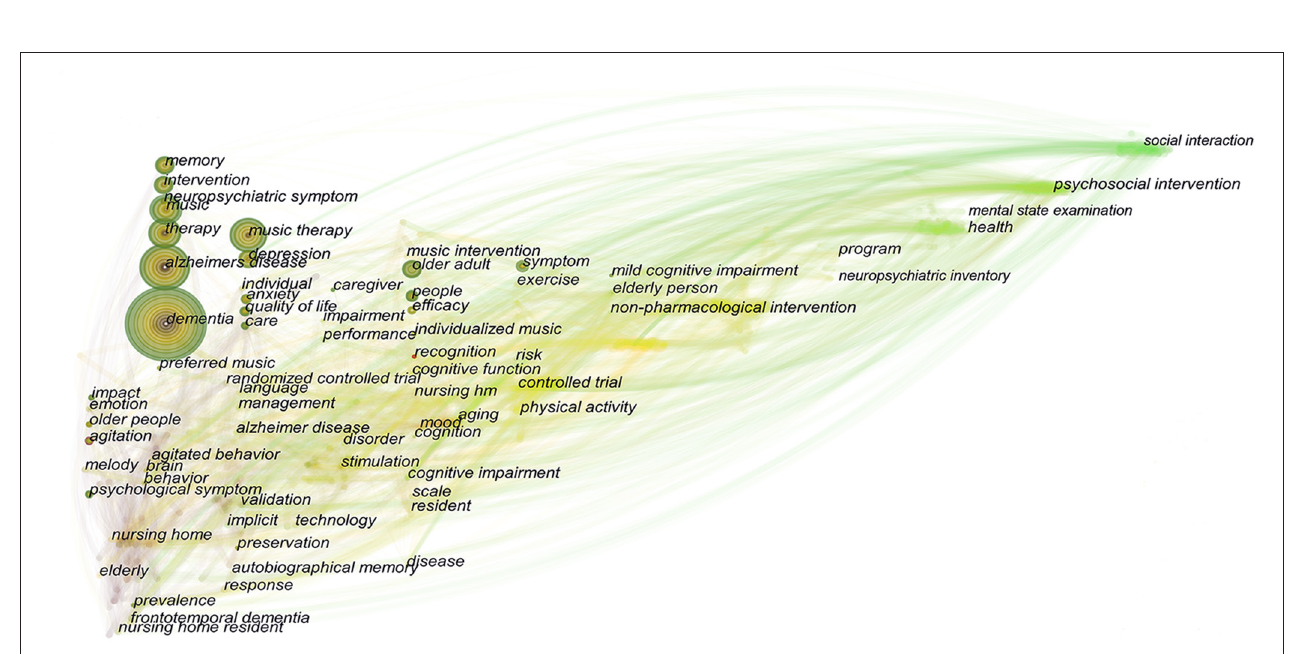
FIGURE 8 | Time zone graph of keywords in articles published in the field of music therapy for dementia from 2010 to 2021.